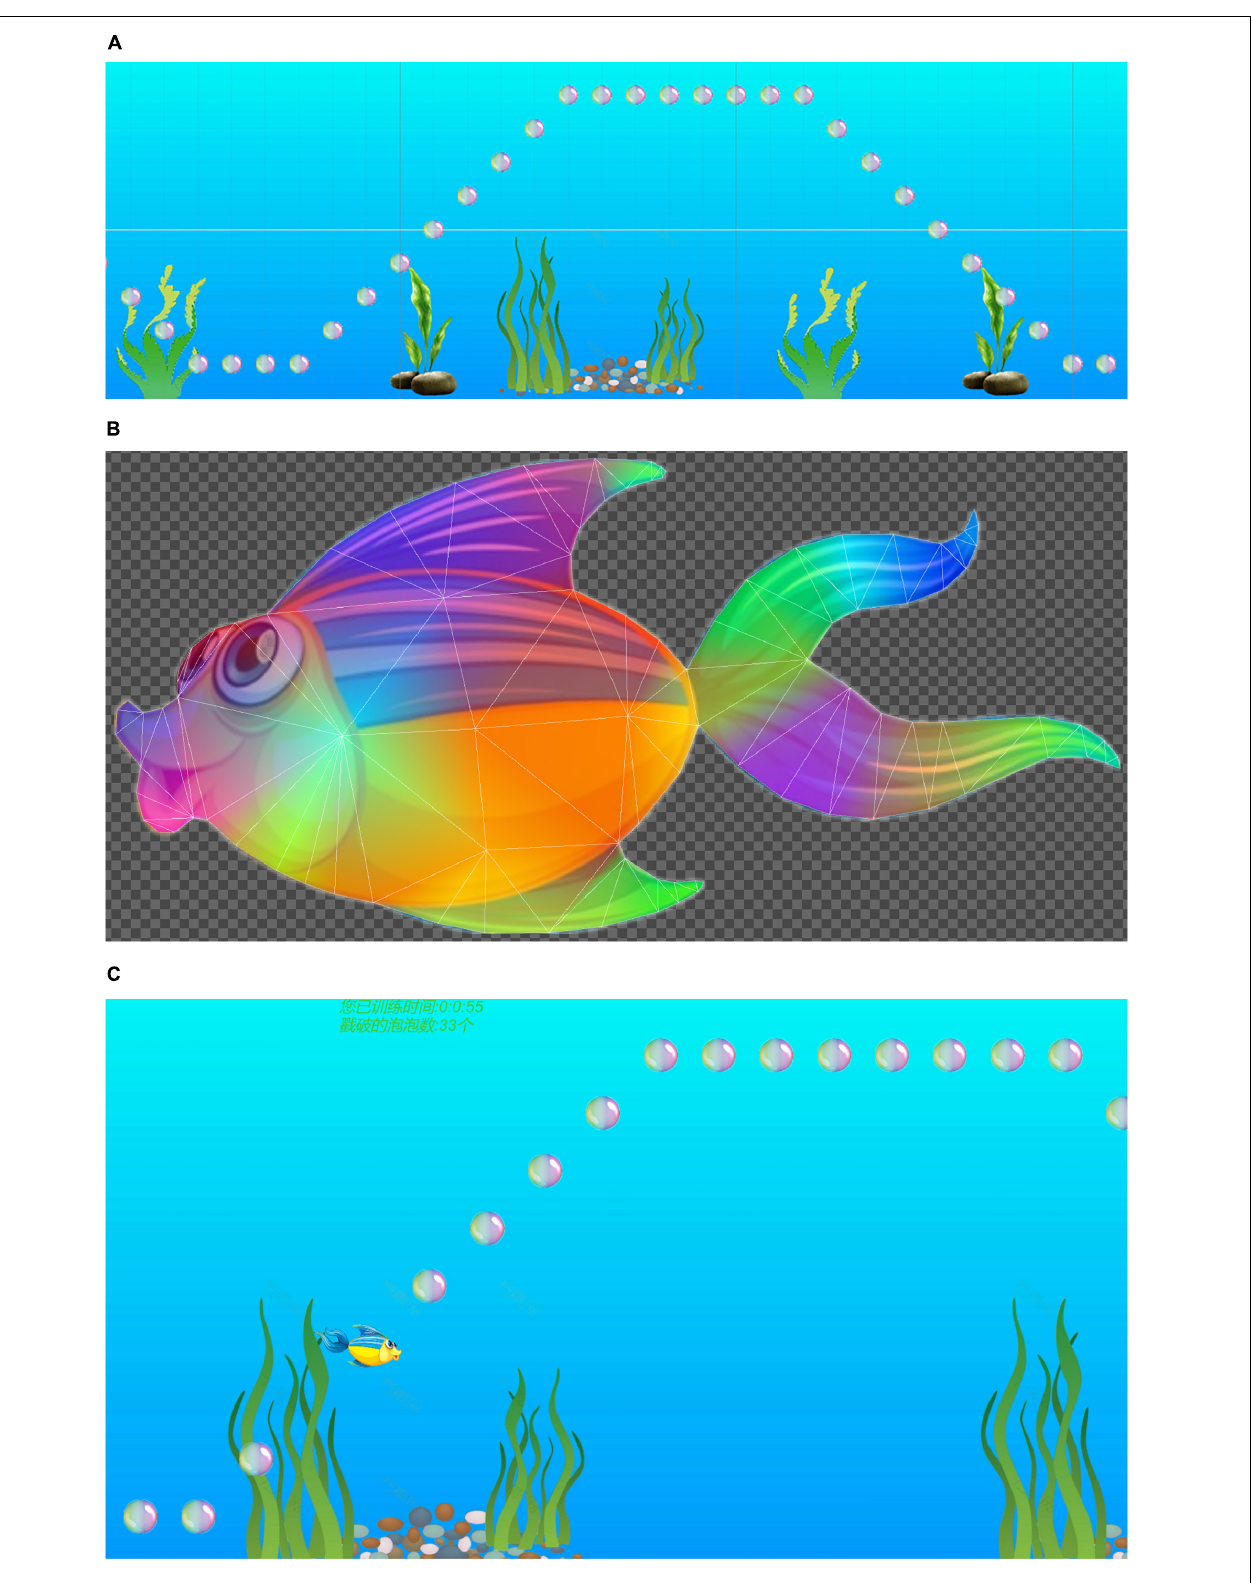
FIGURE 1 | (A) The frequency of the arrangement of bubbles, and the arrangement of bubbles is continuously repeated. (B) In order to increase the enjoyment of the game and improve the enthusiasm of the user, the animation effect of the fish is realized. (C) VR scene includes scores, path, and training time records.